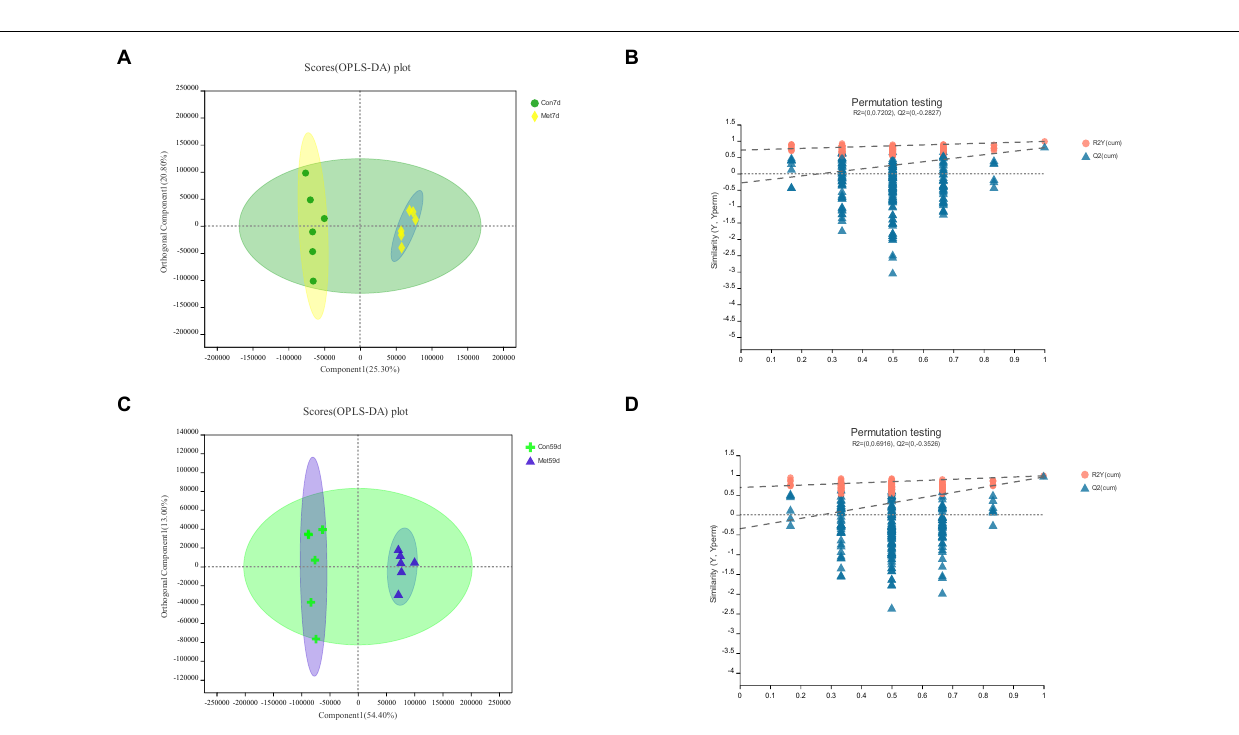
Frontiers in Marine Science |